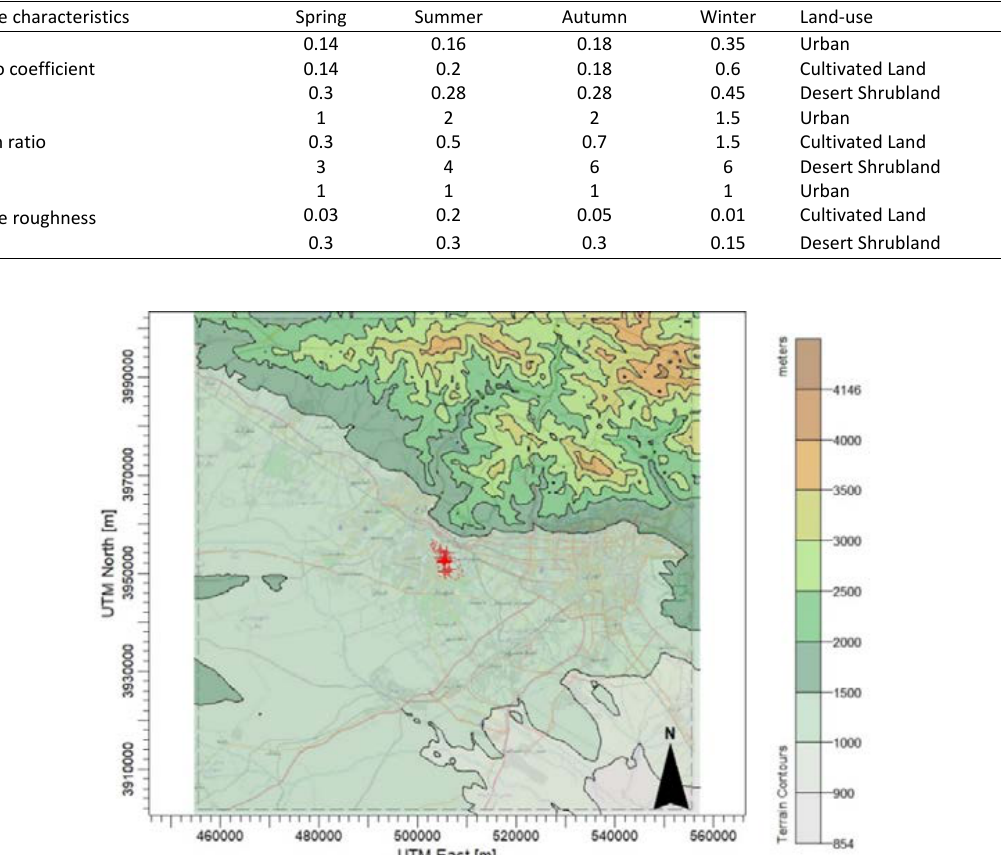
Fig. 3: Map of terrain features of the study area (up to 50 km)